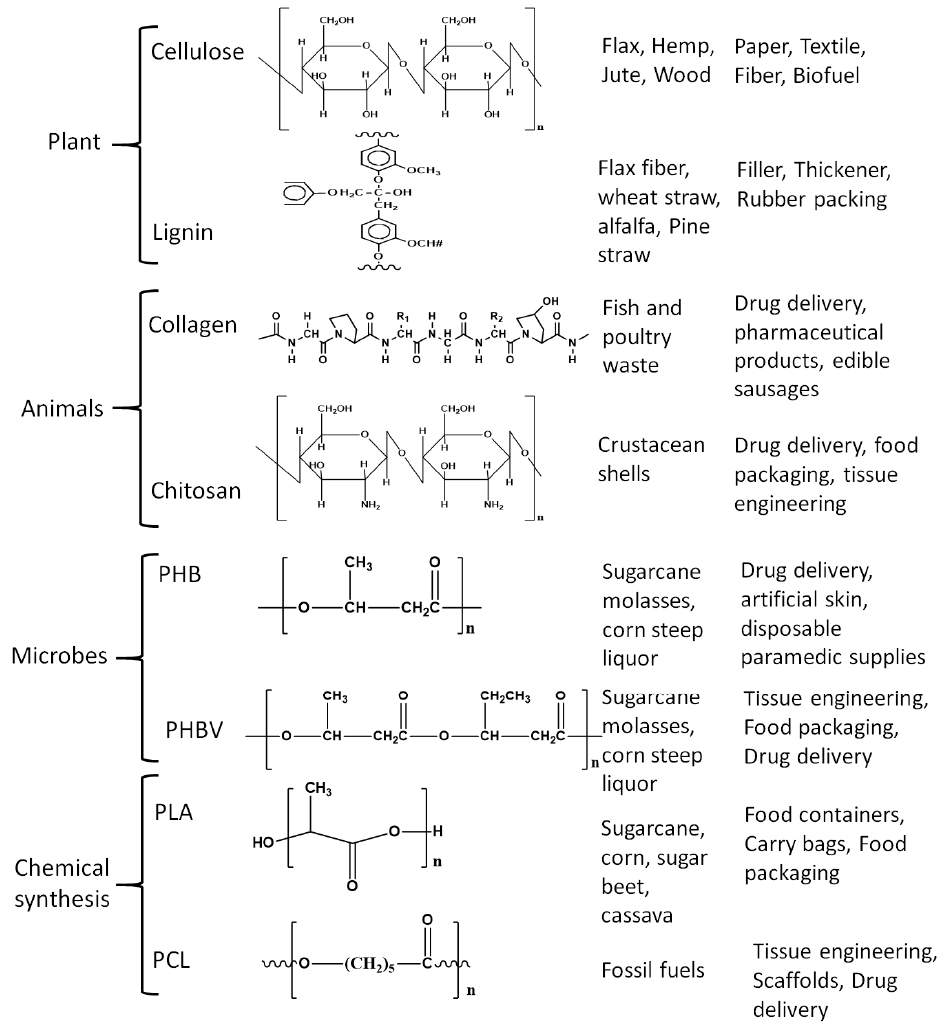
Figure 1. Common biopolymers with their structure, source, and applications.